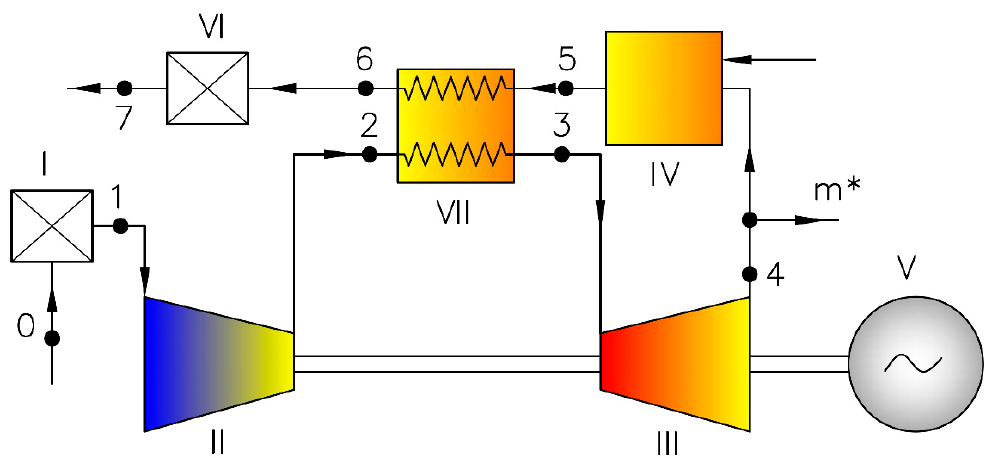
Figure 2. Turbine set operating according to the open cycle with partial bypassing of the external combustion chamber at the turbine exit and with a high-temperature heat exchanger (Variant 2 -V2). I–filter; II–compressor; III–turbine; IV–external combustion chamber; V–electric generator; VI–silencer; VII–regenerator.